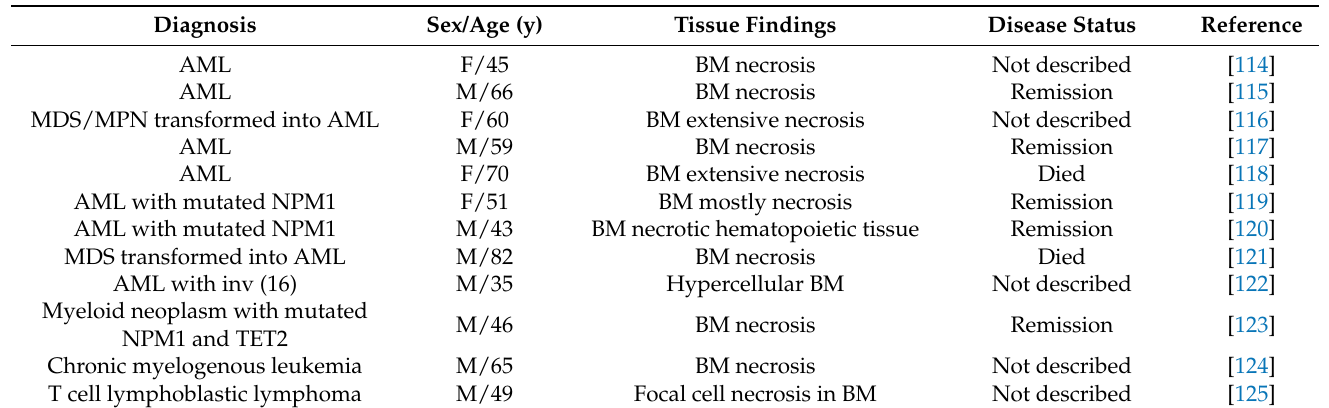
Table 2. Cases related to leukemia with CLC accumulation reported in the